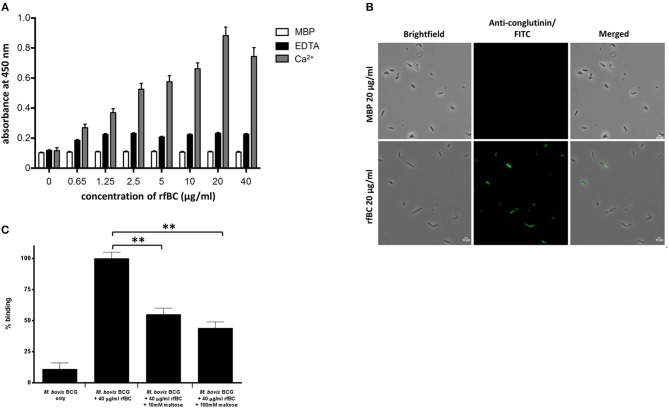
rfBC binds to M. bovis BCG. (A) rfBC binding to M. bovis BCG cells in the presence of Ca2+ with EDTA and maltose-binding protein used as negative controls. Two-fold serial dilutions of rfBC were performed in 40 mM Tris-HCl, 200 mM NaCl, pH 7.4 containing 5 mM CaCl2 or 10 mM EDTA and added to the mycobacteria and allowed to incubate for 2 h. This was followed by incubation with rabbit anti-bovine conglutinin antibody or mouse anti-MBP monoclonal antibody. Then, protein A-HRP was added and developed with the substrate 3, 3′,5,5′-Tetramethylbenzidine (TMB) and the color read at 450 nm. All assays were conducted in triplicate. (B) Direct binding of 20 μg/ml of rfBC to M. bovis BCG, with 20 μg/ml of MBP as a negative control. Cells were incubated for 2 h with either rfBC or MBP, followed by incubation with rabbit anti-bovine conglutinin antibody or mouse anti-MBP monoclonal antibody. Bacterial cells were then washed, fixed and stained with protein A conjugated with fluorescein isothiocyanate (FITC). Bar scale: 10 μm. (C) Competitive inhibition of rfBC binding to M. bovis BCG by maltose. rfBC was pre-treated with either 10 or 100 mM of maltose for 1 h before incubating with M. bovis BCG. Binding of rfBC was detected as described above. The percentage difference in rfBC binding for was calculated with respect to untreated 40 μg/ml of rfBC + M. bovis BCG (100%). Assay was conducted in triplicate. Bars denote ± 2 standard deviations. A one-way ANOVA test was performed on the data to determine significant differences in binding between M. bovis BCG + 40 μg/ml of rfBC (untreated) and 10 and 100 mM maltose. Both comparisons were significant (**p ≤ 0.01).